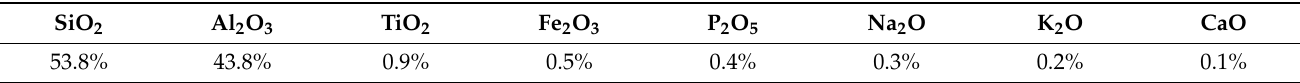
Table 1. Chemical composition of